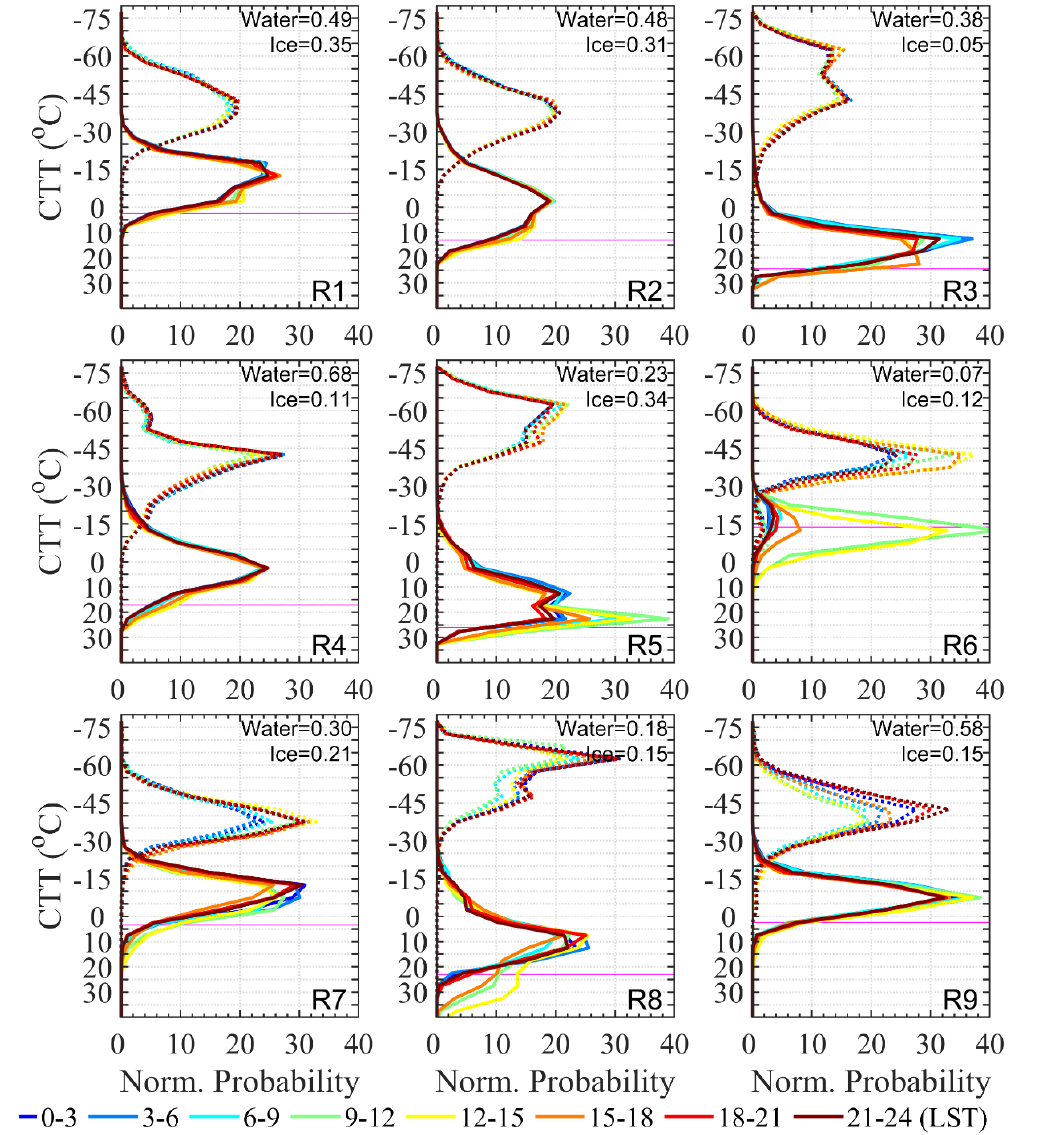
Figure 14. Same as Figure 13 except for the 3-year boreal